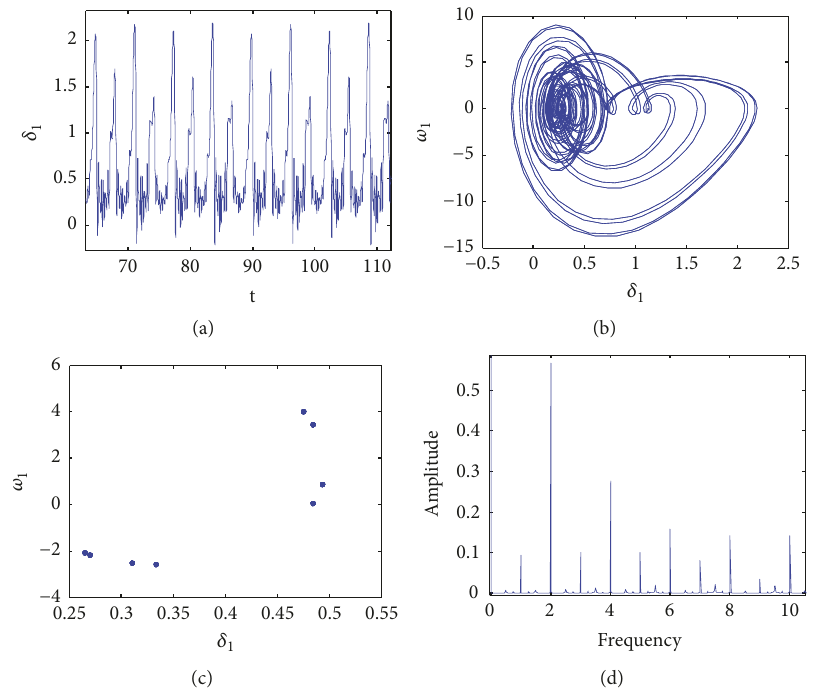
Figure 8: Period 8 motion ( 𝑉 𝐵1 = 0.6382 ). (a) Time history. (b) Phase portrait. (c) Poincar´e map. (d) Frequency spectrum.